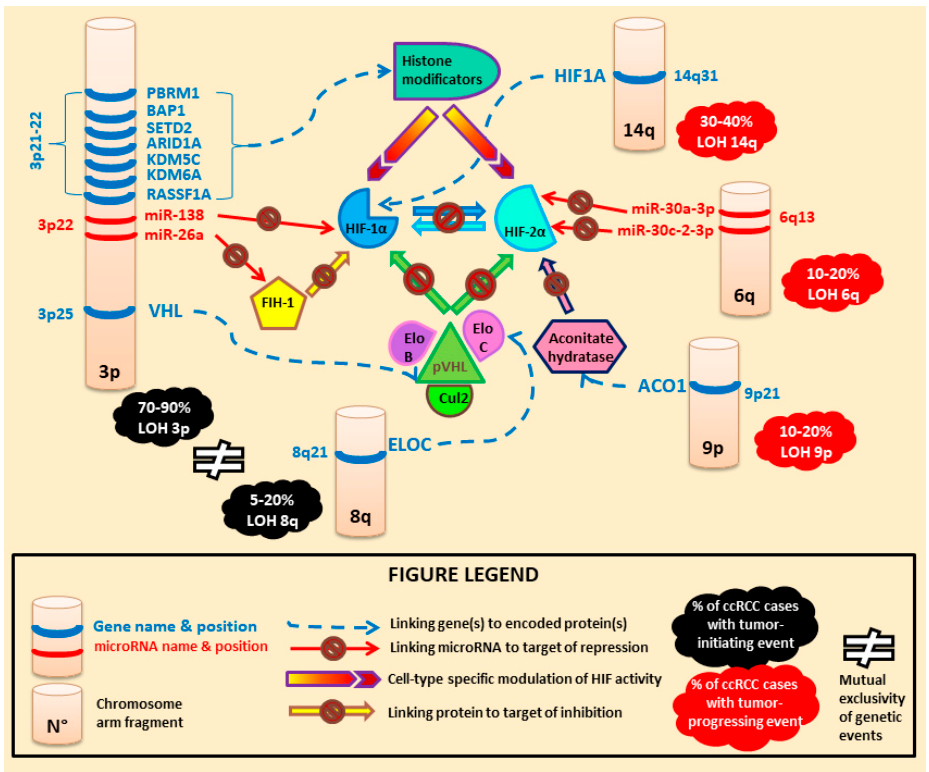
Figure 2. Genetic and epigenetic regulation of hypoxia-inducible factors (HIF) in human kidney cells.